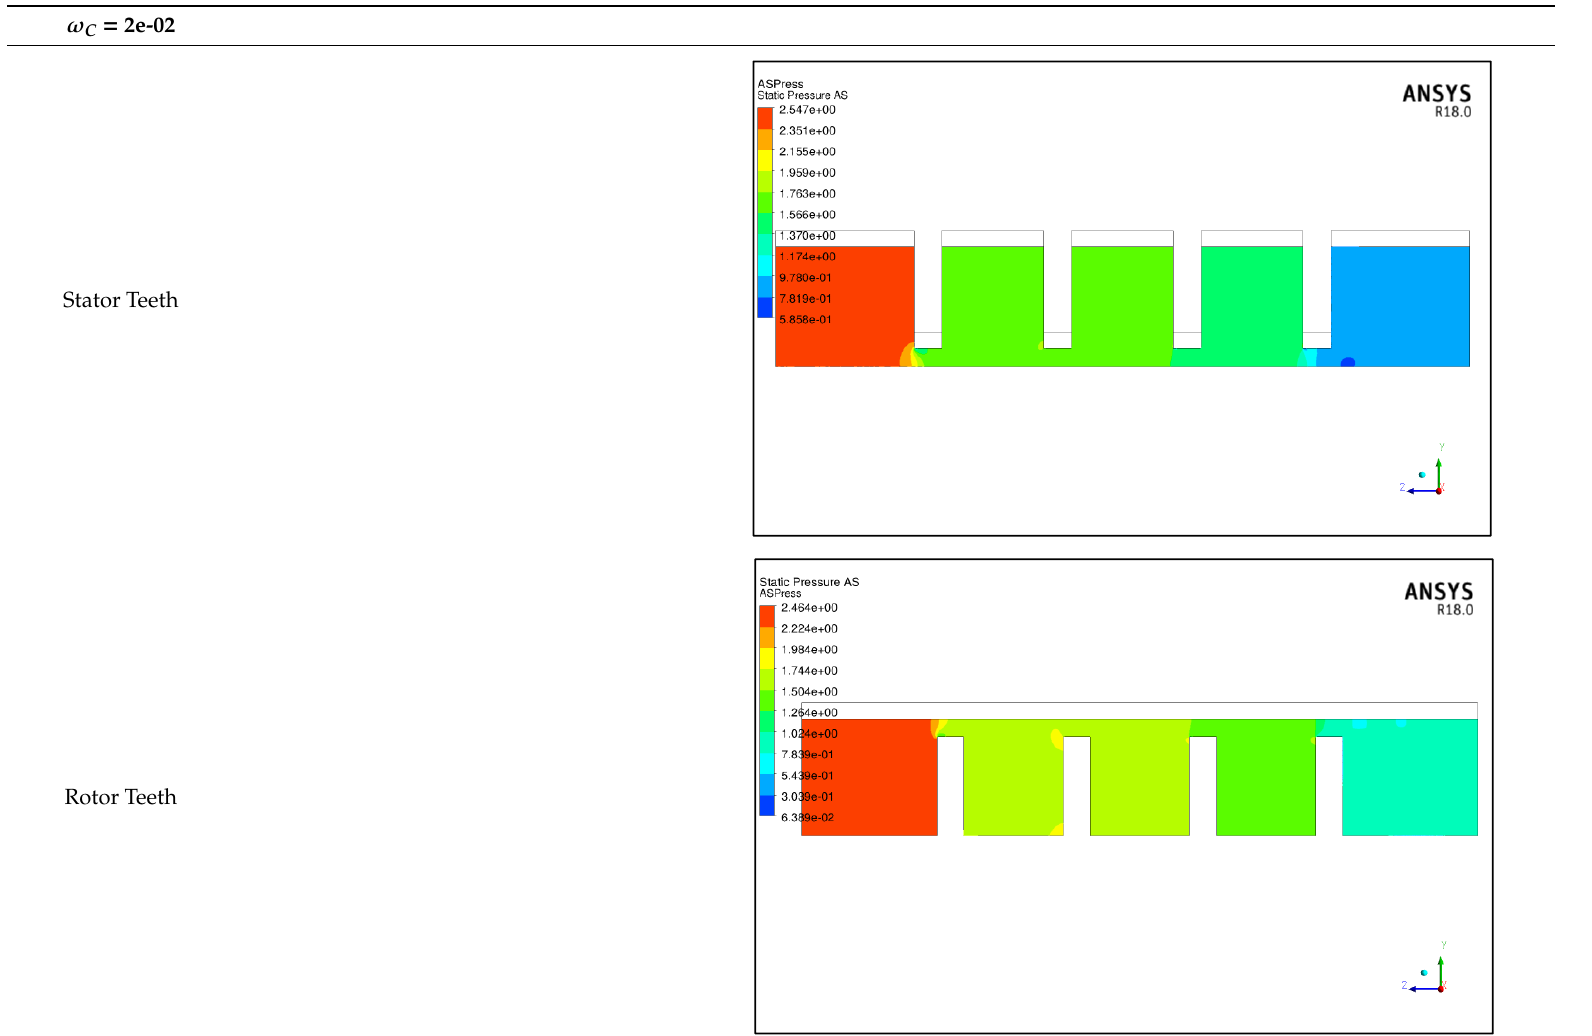
Table A4. Static pressure fields.